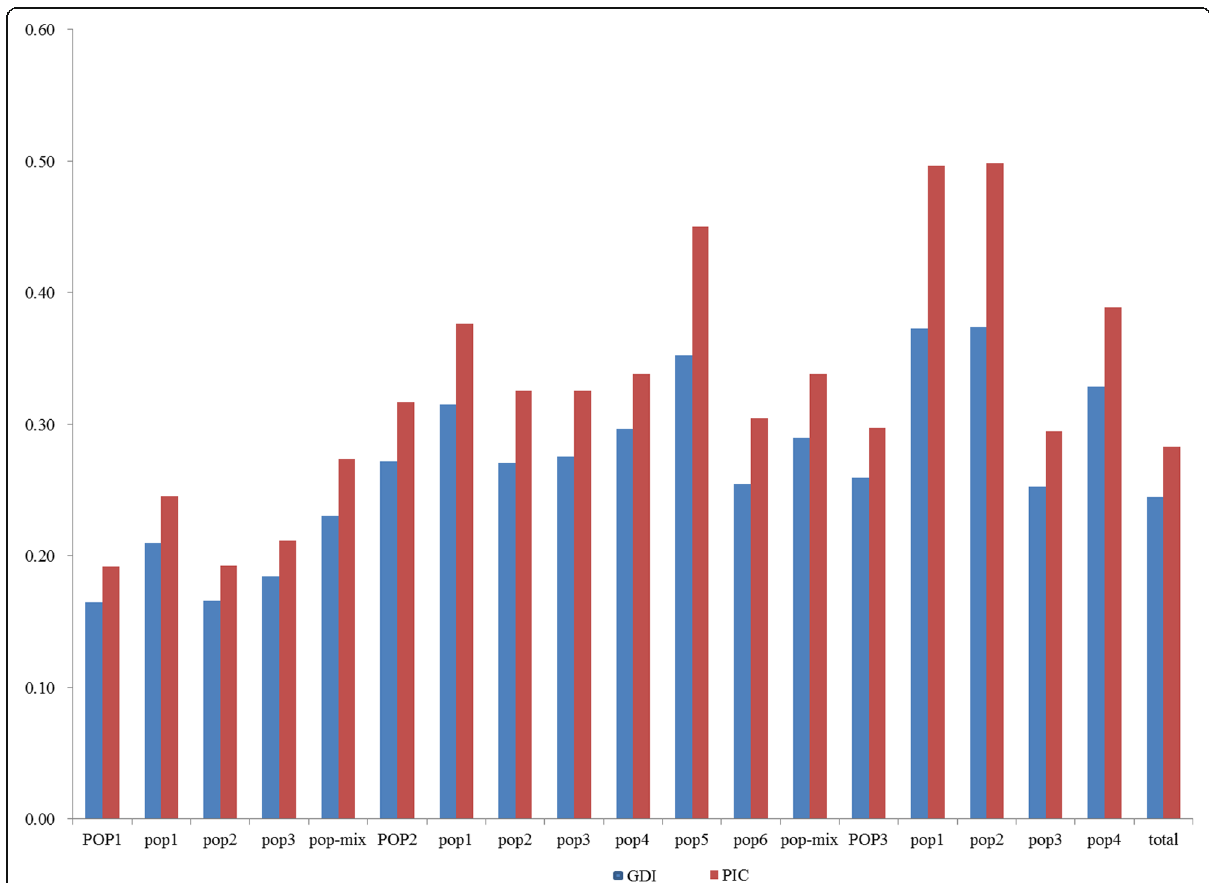
Fig. 6 Comparison between the GDI and PIC among subgroups. GDI: gene diversity index; PIC: polymorphism information